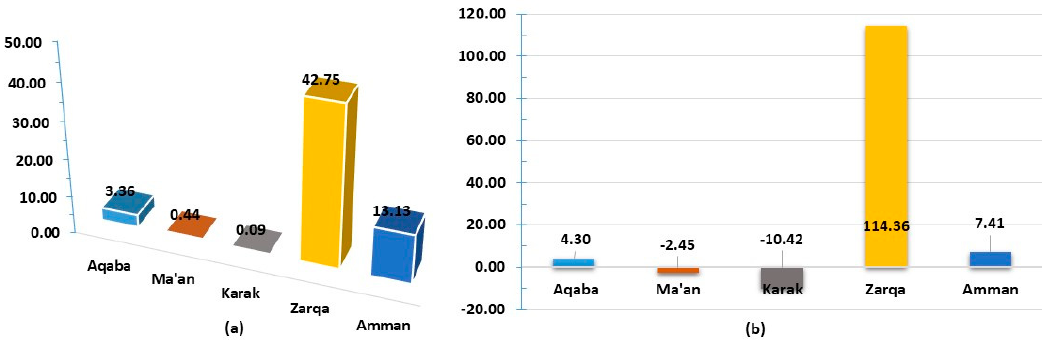
Figure 7. Responses of reclaimed wastewater quality requirements by the major industries.